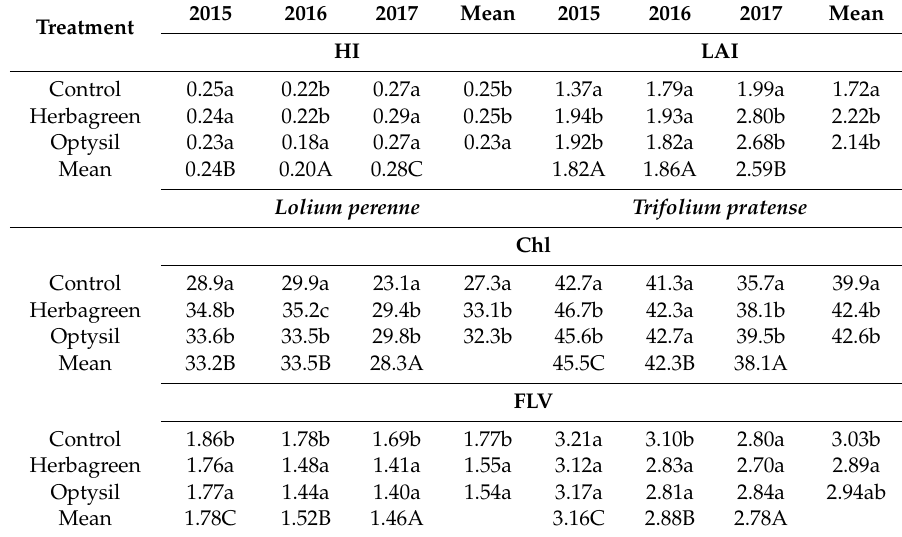
Table 4. Impact of silicon-containing fertilizers (Herbagreen, Optysil) on plant productivity indices: harvest index (HI), leaf area index (LAI) and also chlorophyll index (Chl) and flavonol index (FLV) in L. perenne and T. pratense plants during the study period